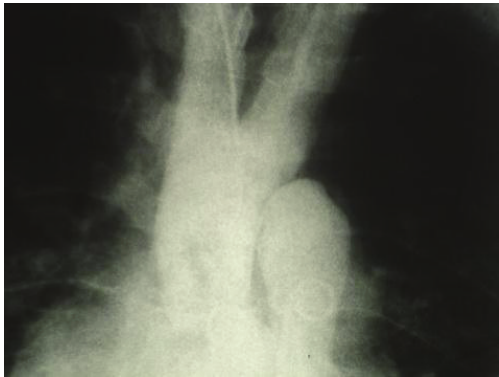
Figure 1: Complete occlusion of proximal portion of descending aorta.